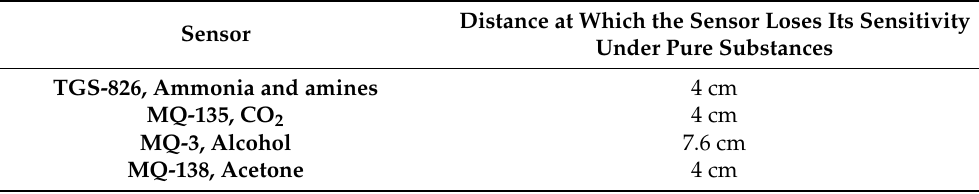
Table 6. Distances at which all four sensors lose their sensitivity under pure